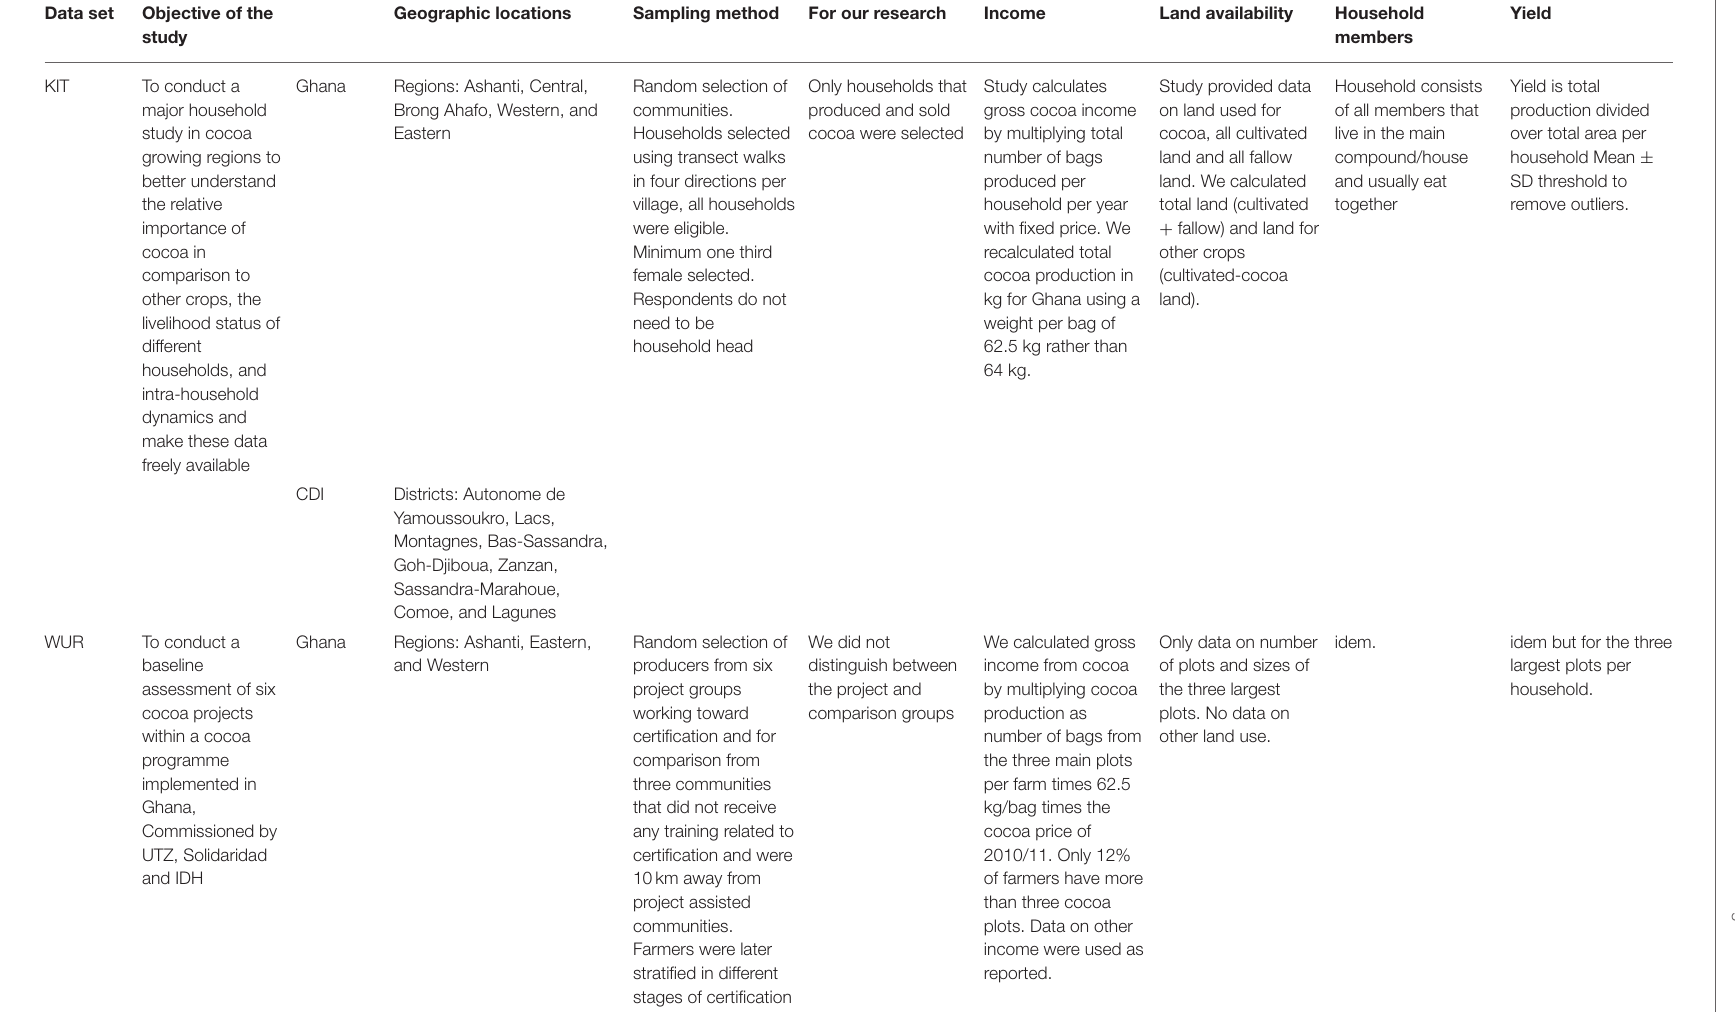
TABLE 1 | Data sets of cocoa-producing households surveyed in Côte d’Ivoire (CDI) and Ghana. Data